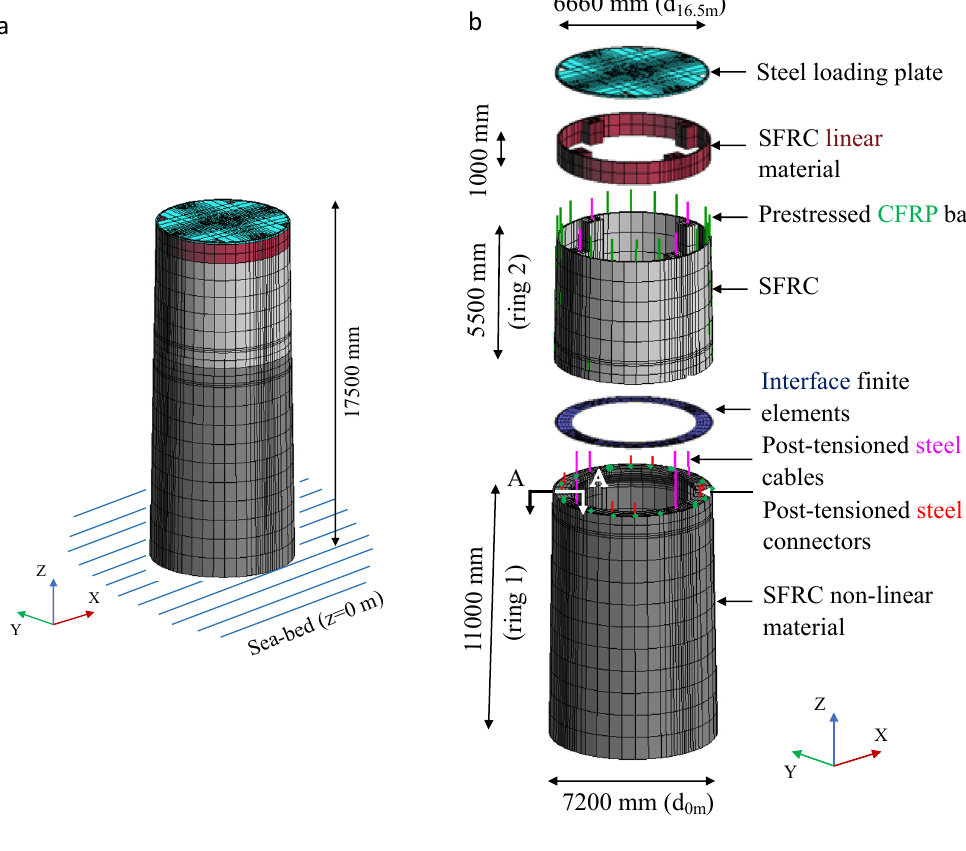
Figure 3. Model “t_s1”: (a) Full model and (b) Components of the